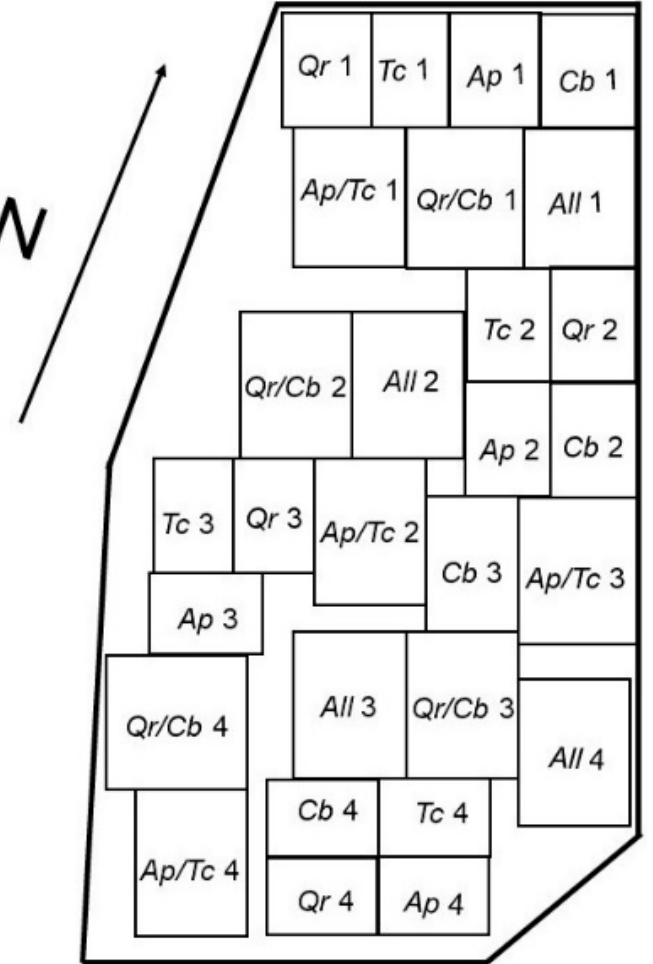
Figure 1. Schematic overview of the plot arrangement of the TreeDivNet experimental site B-Tree. The four species, Acer platanoides L. ( Ap ), Tilia cordata Mill. ( Tc ), Quercus robur L. ( Qr ), Carpinus betulus L. ( Cb ), are replicated as monocultures, two species polycultures ApTc and QrCb and as four species polycultures All. Numbers show the block number.